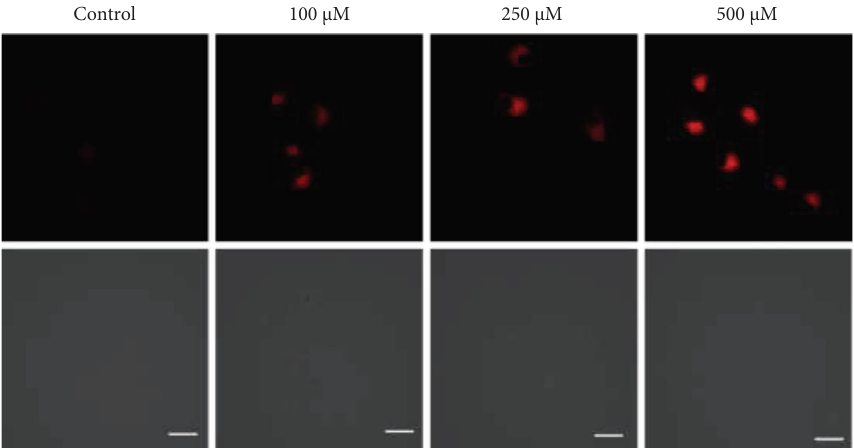
Figure 3: Imaging of exogenous ONOO − in HeLa cells. Te cells were added with diferent level (100 μ M, 250 μ M, and 500 μ M) of SIN. Te scale bar is 20 μ m.